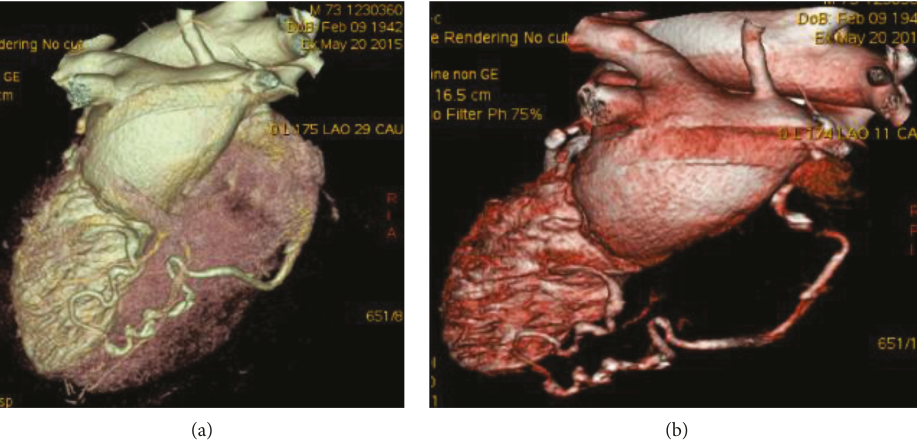
Figure 3: Three-dimensional (3D) reconstruction of the right coronary artery and fi stula using computed tomography